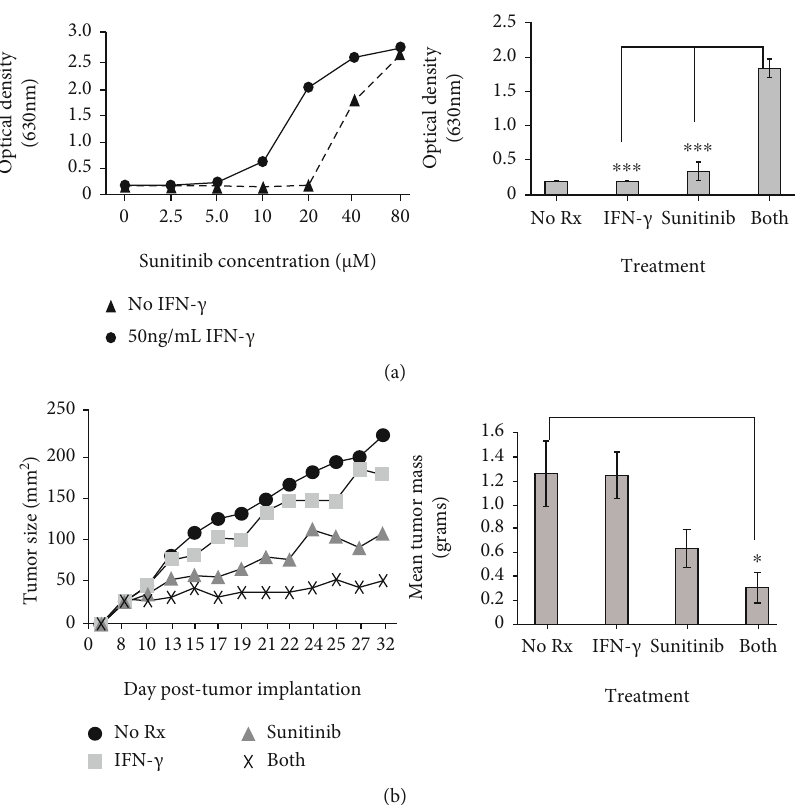
Figure 7: Combination therapy with sunitinib and recombinant IFN- γ suppresses tumor growth in an orthotopic murine model of HER-2 pos breast cancer. (a) Rat HER-2 (neu)-transgenic TUBO breast carcinoma cells were cultured with increasing concentrations (0-80 μ M) of sunitinib in the presence (circles) or absence (triangles) of 50ng/mL recombinant murine IFN- γ . After 72 hours of treatment, metabolic activity was measured via the Alamar Blue assay (left panel). Right panel displays the statistical analysis of di ff erences in dye metabolism between treatment groups at the optimal drug concentration of 20 μ M. (b) TUBO cells ( 2 : 5 × 10 5 ) were implanted into the fat pad of the breast of female balb/c mice. Seven days later, therapy commenced consisting of i.p. administration of IFN- γ (10 μ g/mouse), sunitinib (1 mg/mouse), both treatments, or mice left untreated (control). Drug and cytokine therapy was supplied in 3 cycles (days 7-10, 16-18, and 24-25). Tumors were measured periodically using calipers to determine growth kinetics (left panel). On day 32, mice were sacri fi ced, tumors were excised and weighed, and average tumor mass for each treatment group was determined (right